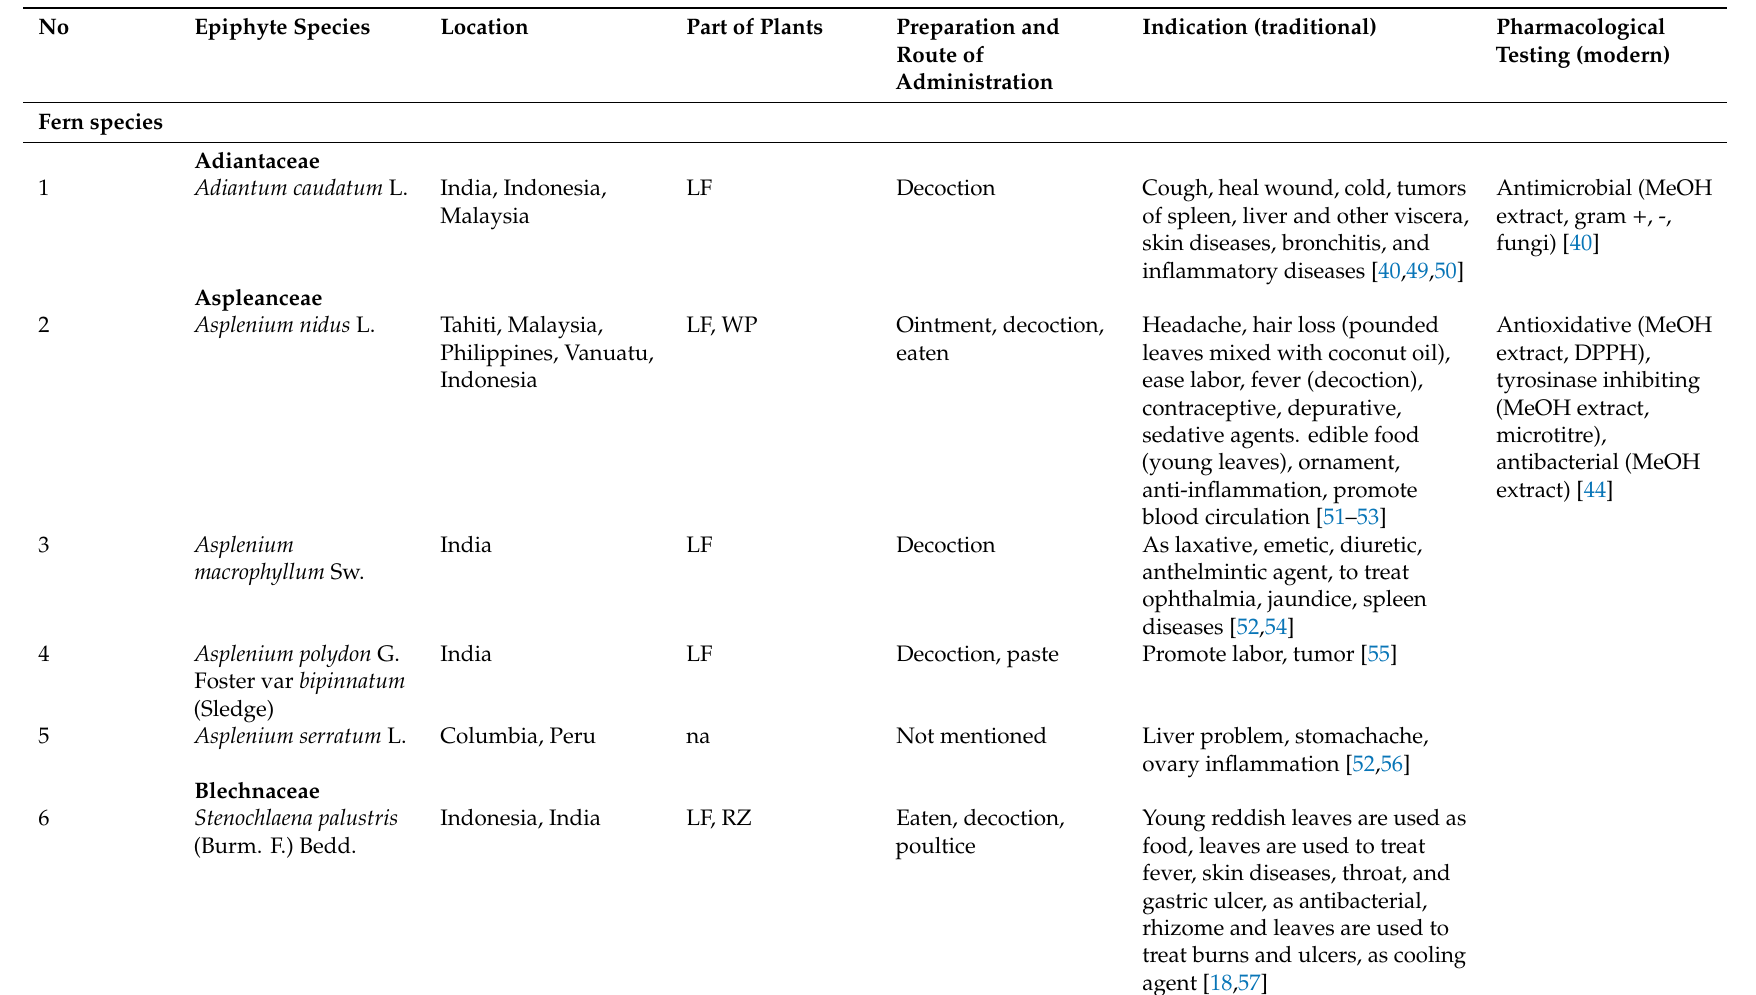
Table 1. Ethnopharmacological database of epiphytic medicinal